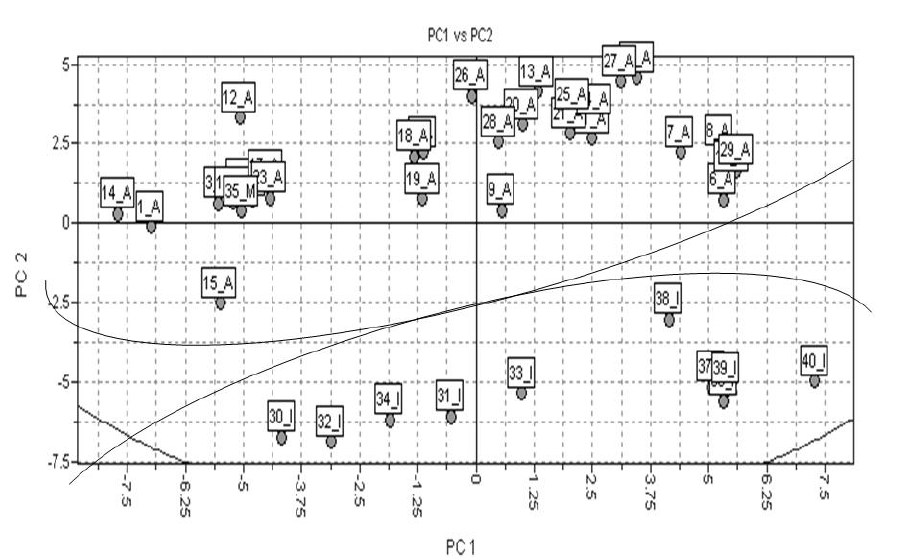
Figure 4. Scores plot from PCA, where active compounds, compounds having medium activity, and inactive compounds are represented as A, M, and I, respectively.